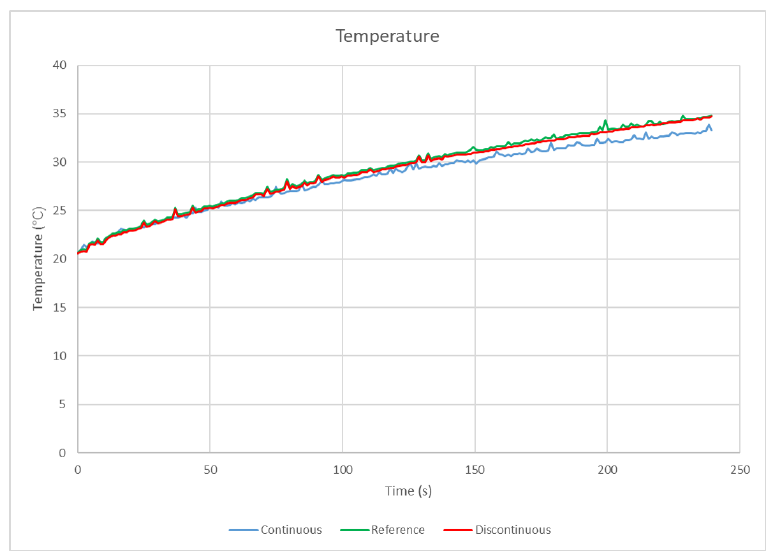
Figure 15. Temperature of all modules.